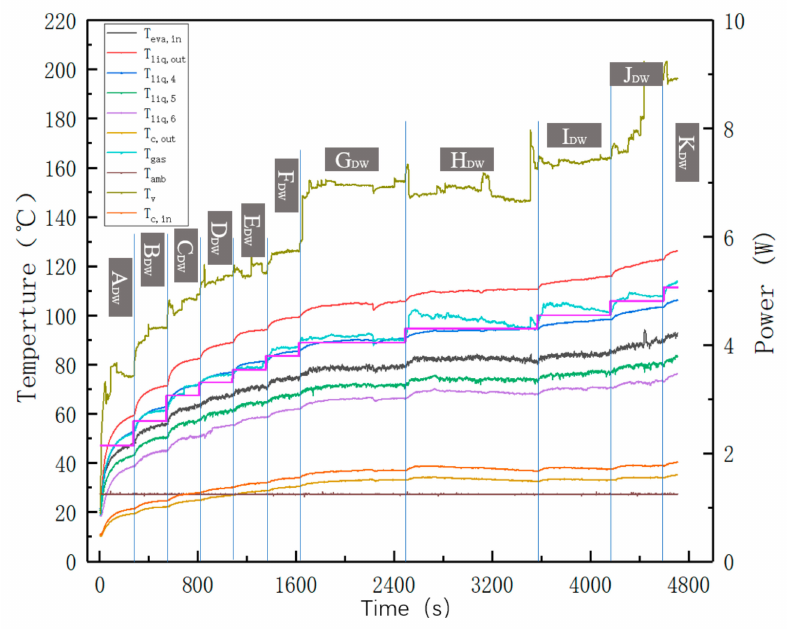
Figure 6. Relationship among the temperature and power of s-UTLHP and the time. T eva,in is the inlet temperature of the evaporation chamber; T liq,out is the outlet temperature of the liquid pipeline; T liq,4,5,6 is the temperature of the liquid pipeline, evenly arranged along the liquid return direction; T c,out is the outlet temperature of condensation chamber; T gas is the temperature of the vapor phase pipeline; T amb is the ambient temperature; T v is the temperature of the evaporation chamber; and T c,in is the inlet temperature of the condensation